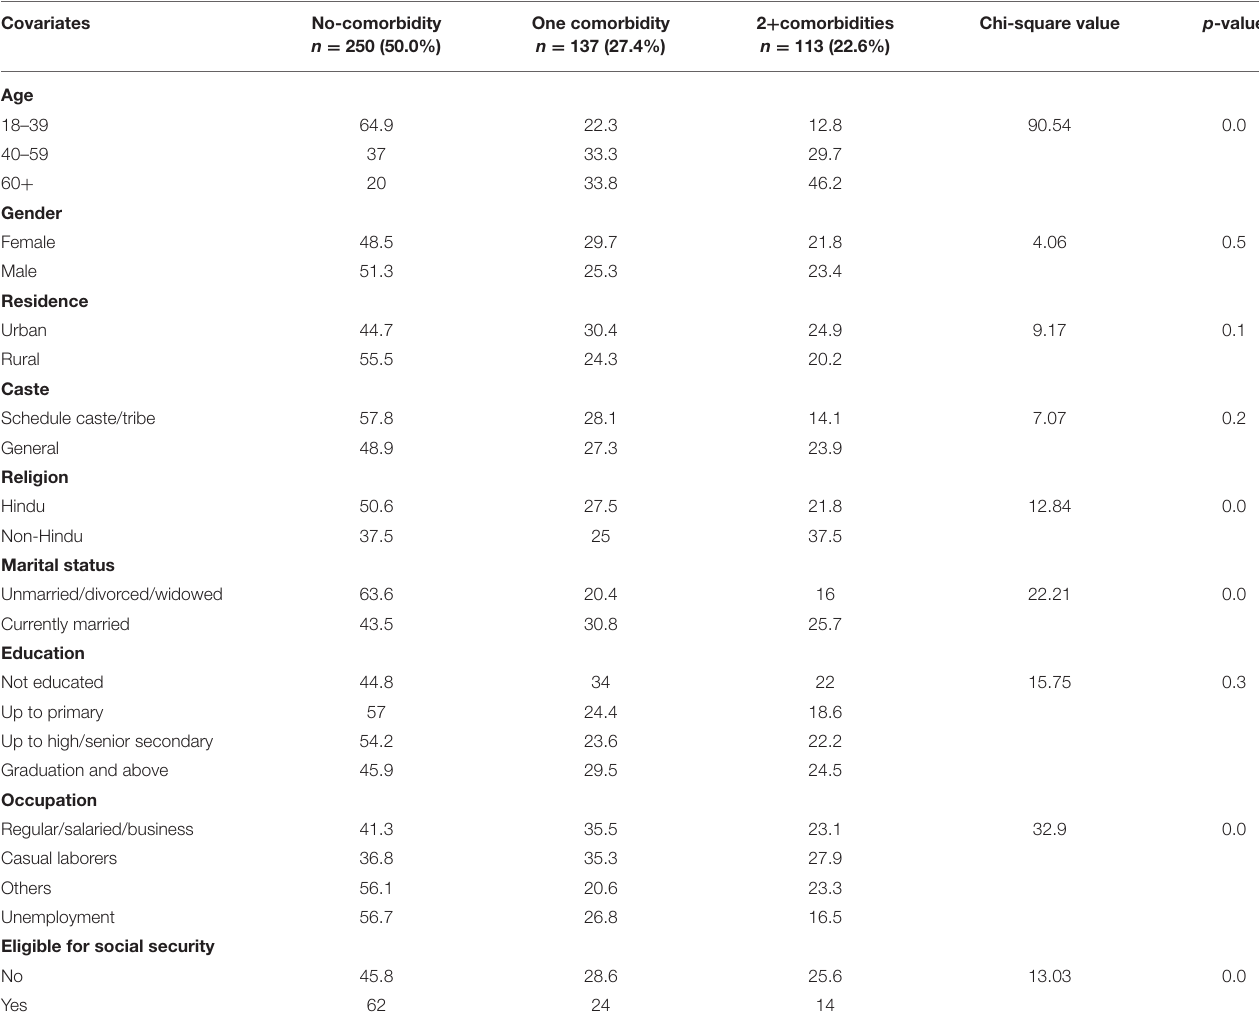
TABLE 2 | Distribution of study participants according to the presence of physical comorbidities ( N = 500). Covariates No-comorbidity